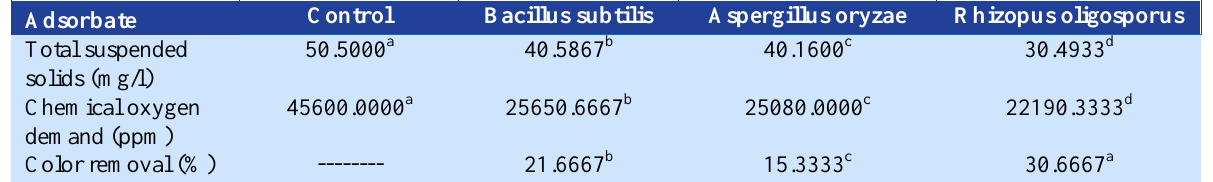
Table 1. The effect of different bioflocculants on dairy wastewater properties